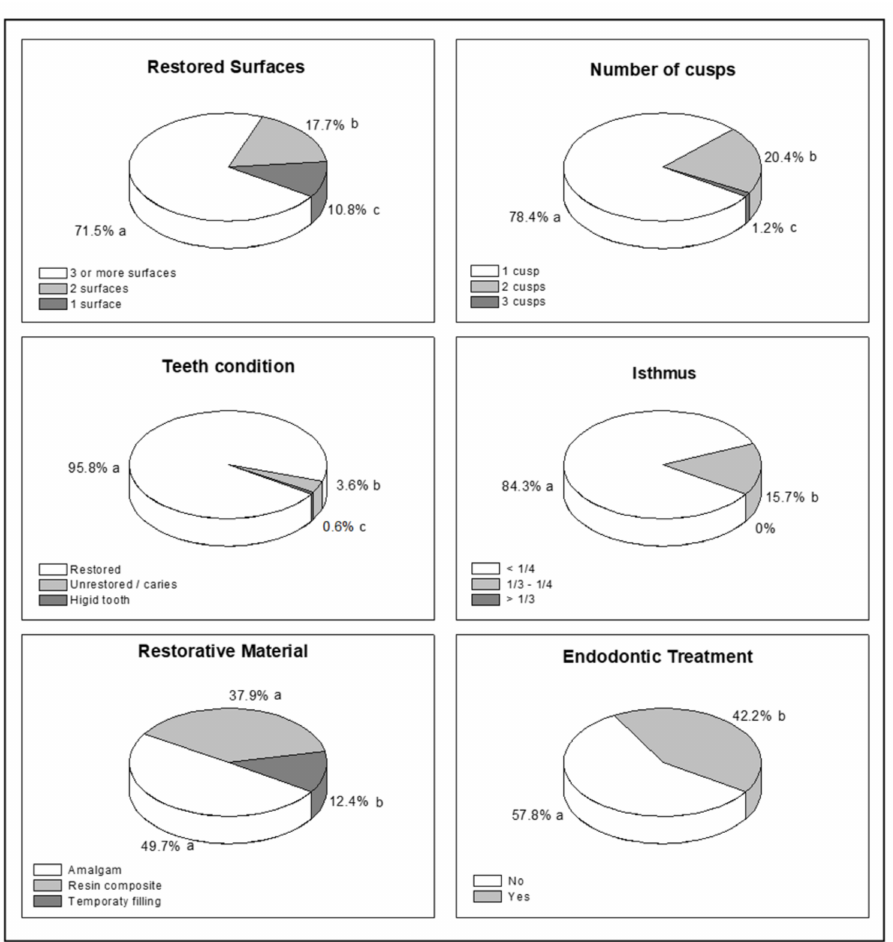
Figure 1. Relative frequency of variables related to teeth characteristics. Groups with the same lowercase letters indicate absence of statistical difference ( α = 0.05; Fisher exact